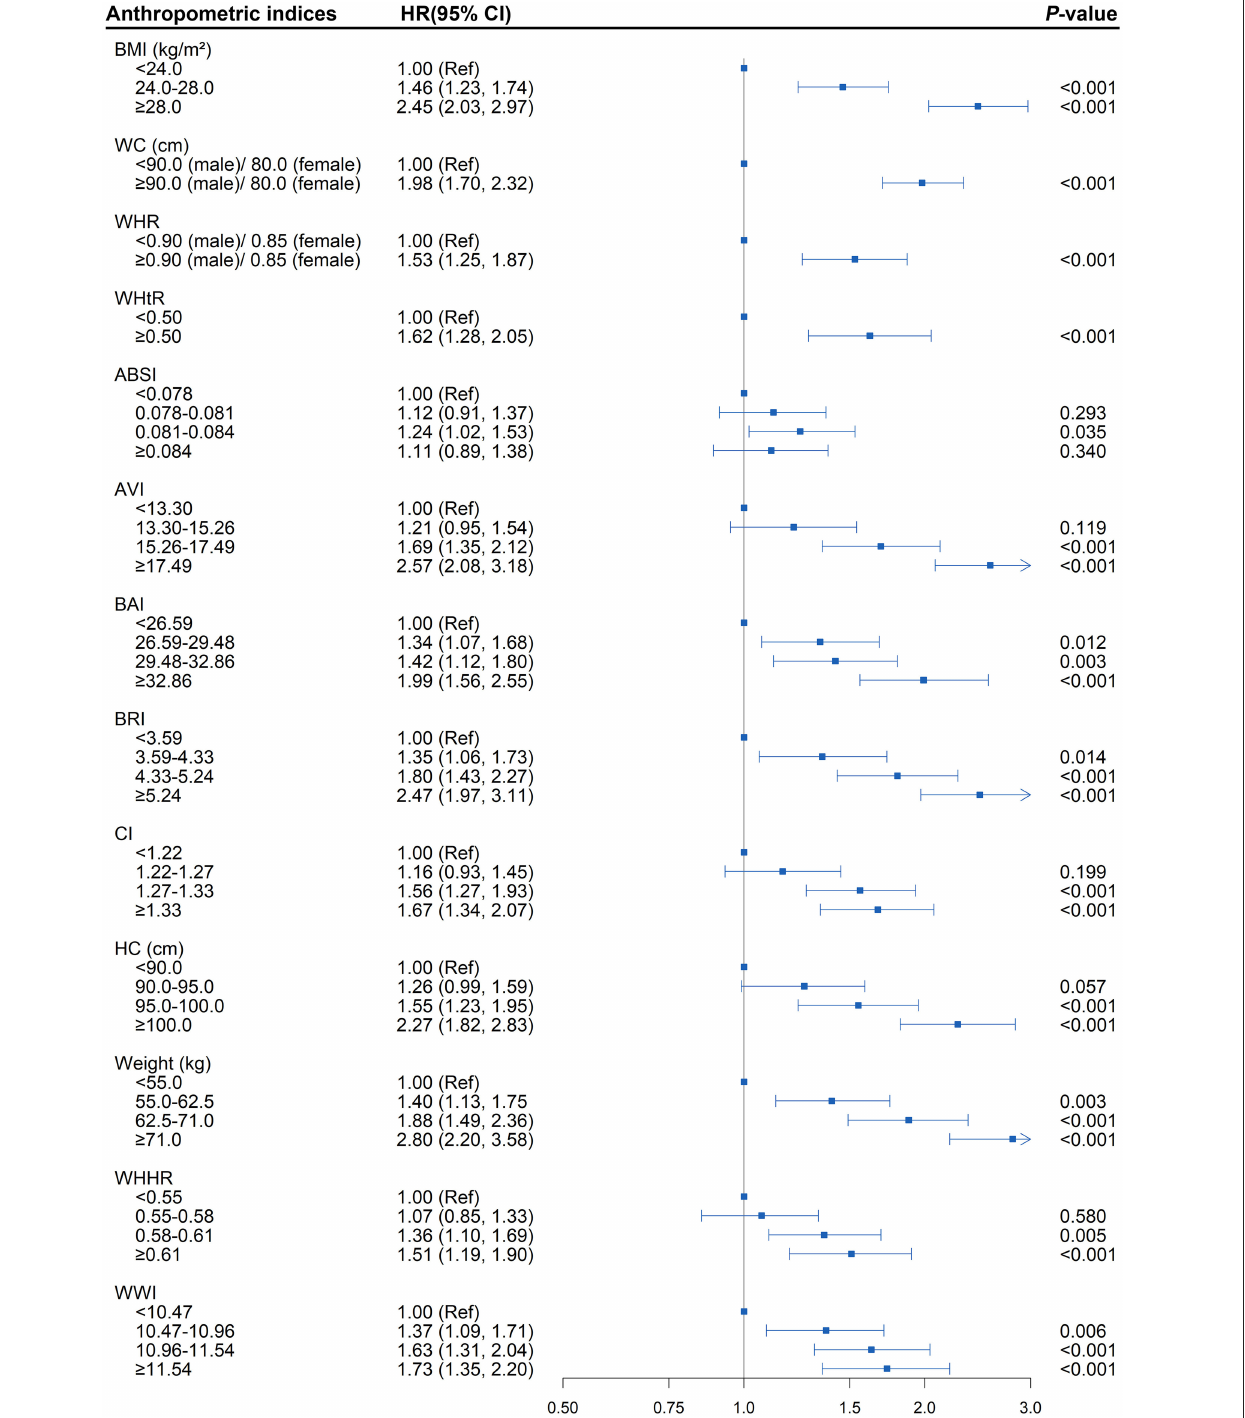
Frontiers in Cardiovascular Medicine | www.frontiersin.org